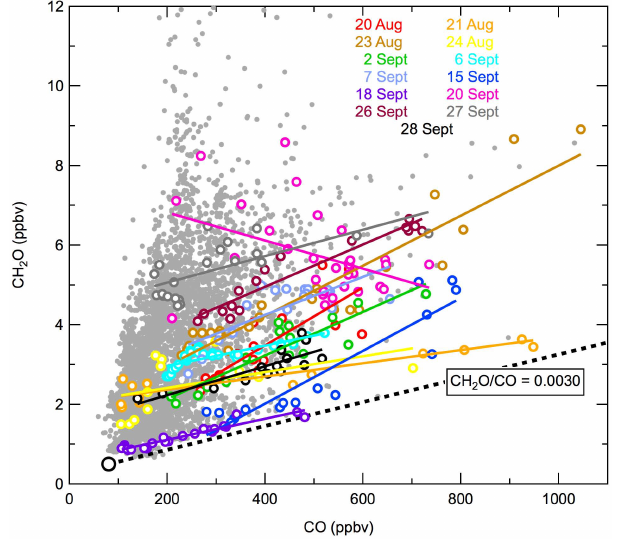
Fig. 4. Relationship between CH 2 O and CO observed at Moody Tower during TRAMP. Gray points include all data with CH 2 O mixing ratios ≤ 12ppbv. Small circles color-coded by date indi- cate the morning traffic peak data discussed further in the text. The solid colored lines indicate the linear, least-squares fits to the re- spective color-coded data. The large black circle indicates the Cen- tral Gulf of Mexico mixing ratios reported by Gilman et al. (2009), and the heavy, dotted black line indicates the expected mixing ratio enhancements from primary emissions of CH 2 O and CO in a ratio of 0.3%.